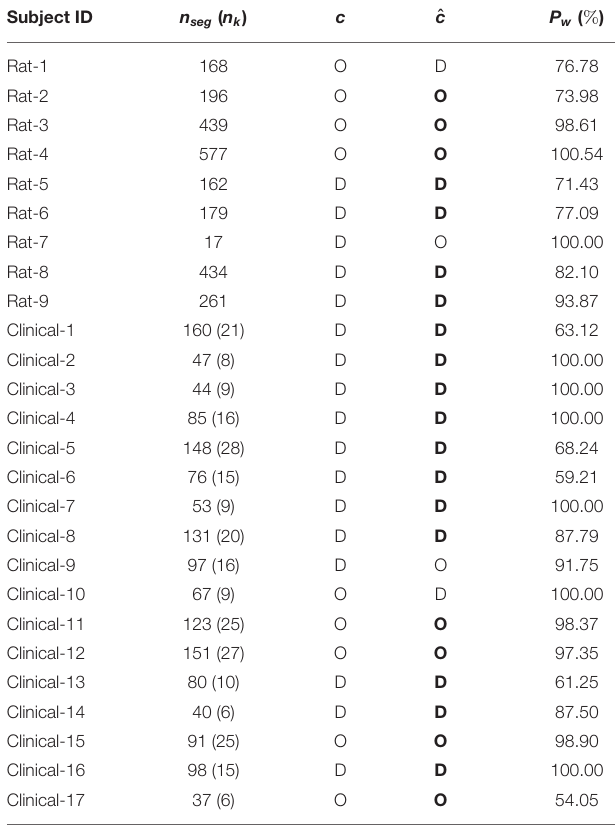
Bold values indicate correct predictions by the machine learning algorithm. i.e. c = ˆ